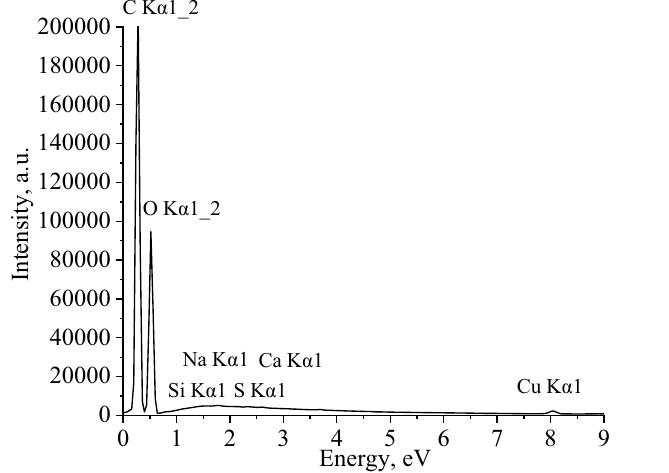
Figure 21. Energy-dispersive spectrum of methylcellulose film modified with 0.8% CuO nanoparticles.